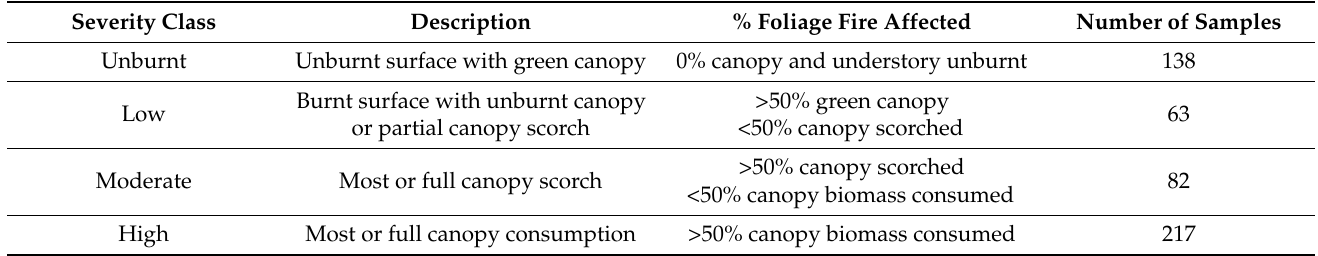
Table 4. Classification of the fire severity, including the number of samples for each class.